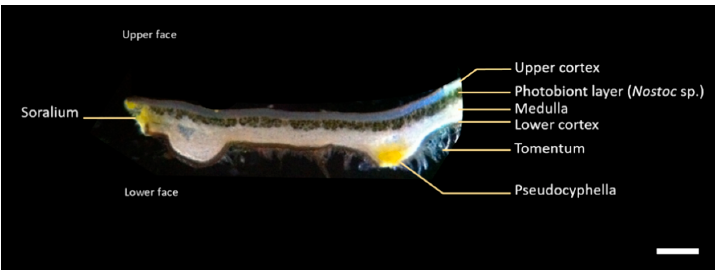
Figure 2. P. crocata thallus cross section that shows four distinctive layers and the basal part fixed to the substrate, called tomentum. Scale bar corresponds to 500 µm.